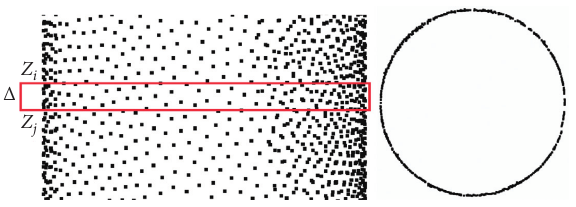
Figure 10: Slice diagram of the cylinder point cloud.